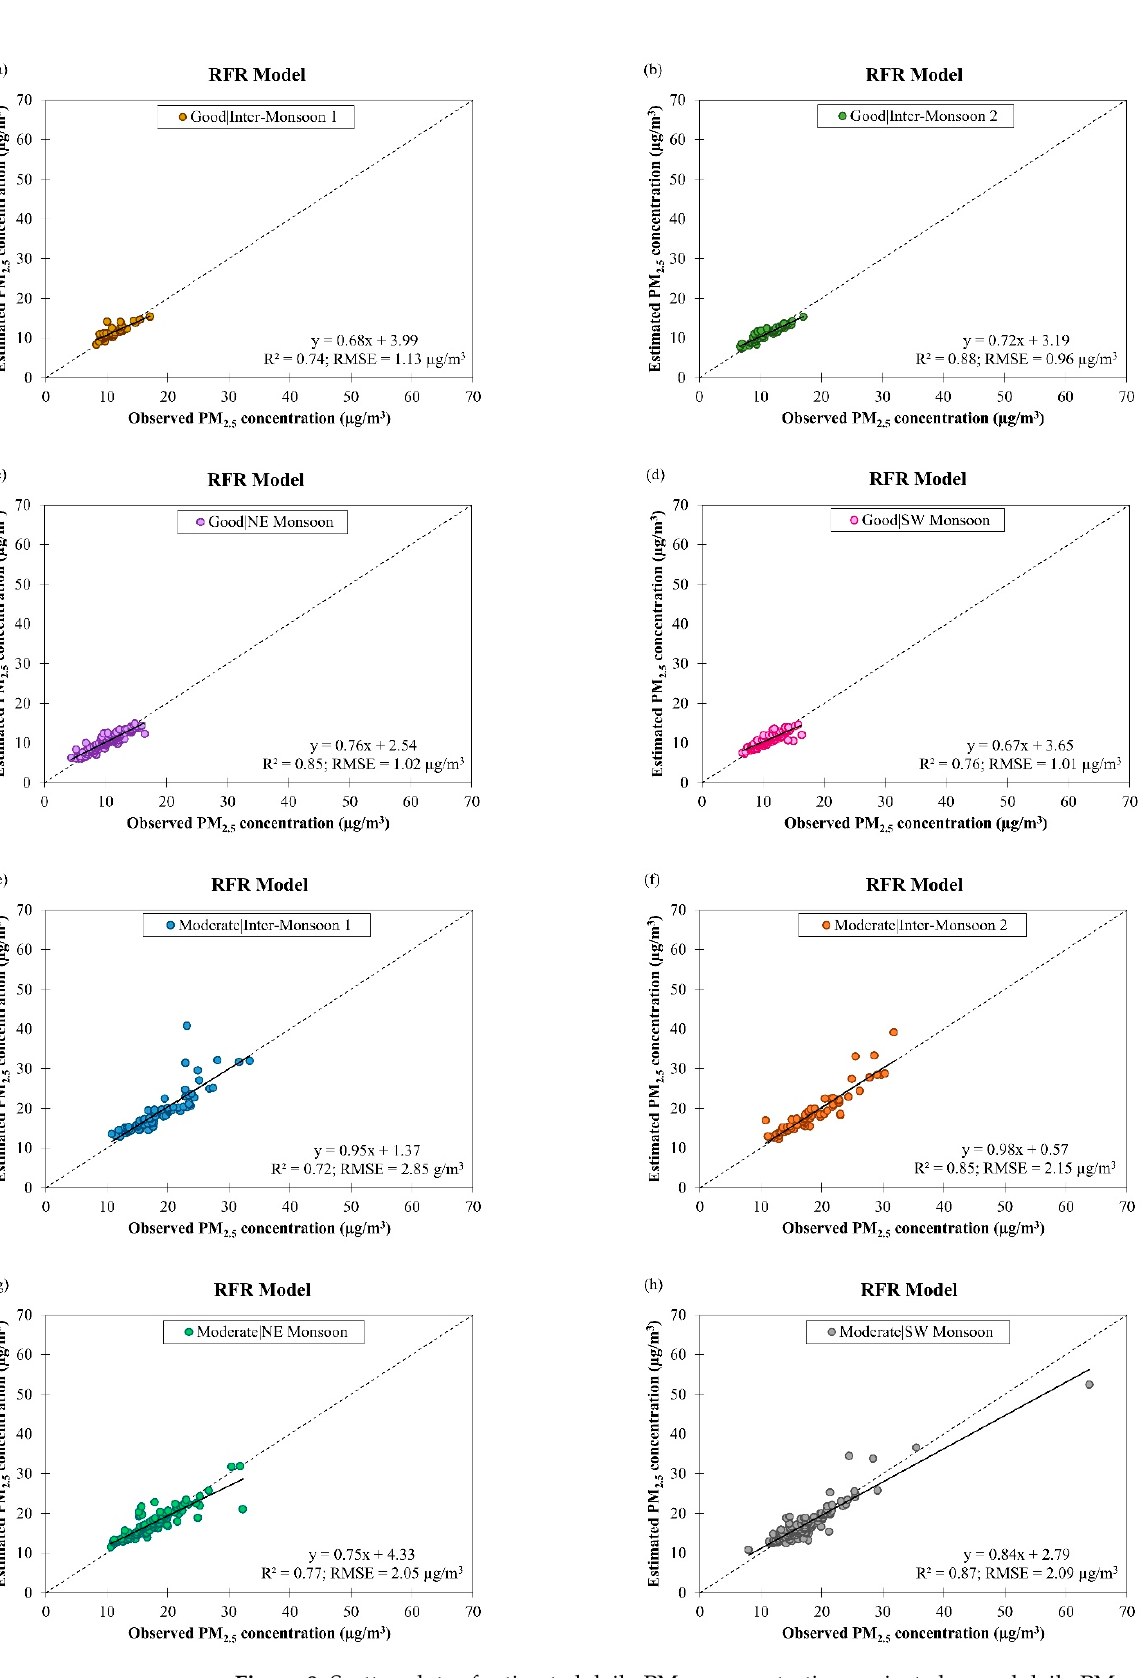
Figure 8. Scatter plots of estimated daily PM 2.5 concentration against observed daily PM 2.5 concen- tration by RFR model for ( a – d ) good and ( e – h ) moderate air quality conditions during different monsoon seasons in Singapore from March 2016 to February 2018.